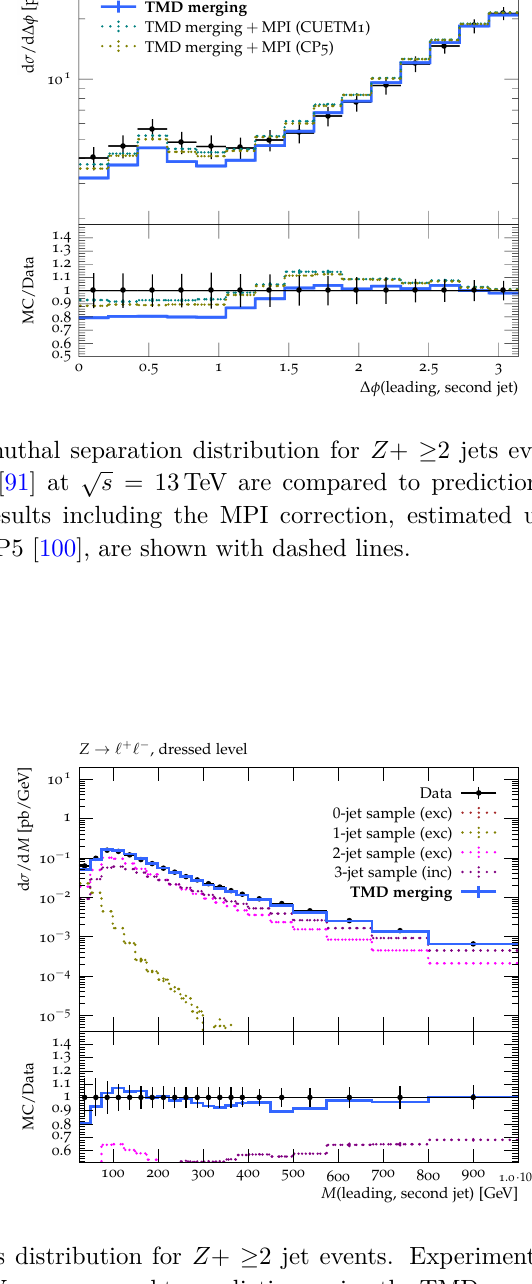
Figure 16 . Di-jet mass distribution for Z + ≥ 2 jet events. Experimental measurements by AT- √ LAS [91] at s = 13 TeV are compared to predictions using the TMD merging calculation. Separate contributions from the different jet samples are shown. All the jet multiplicities are obtained in exclusive (exc) mode except for the highest multiplicity which is calculated in inclusive (inc)